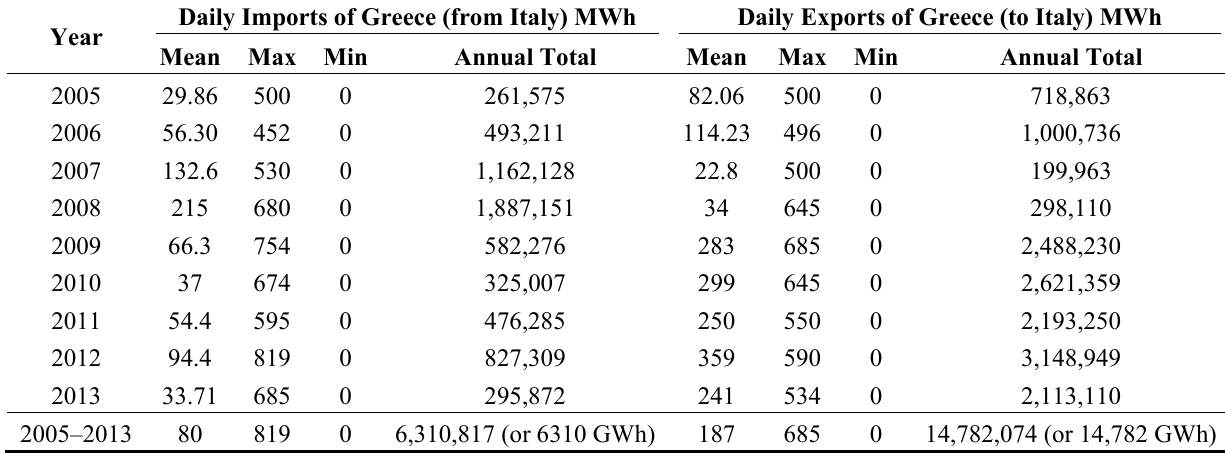
Table 1. Sum of Imports and Exports of Electricity between Greece and Italy, GWh.